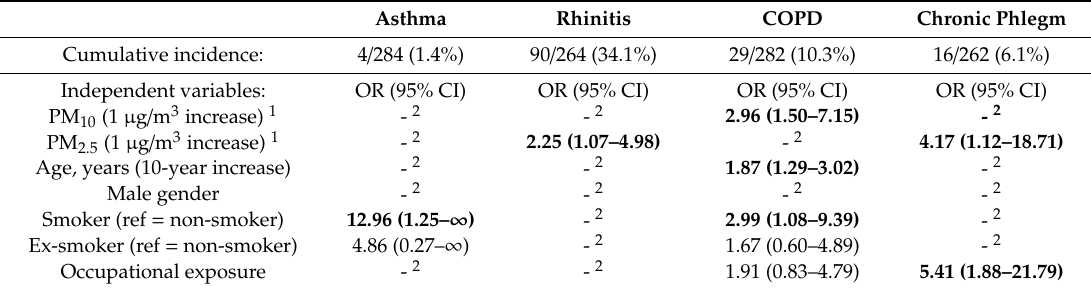
Table 2. Associations (odds ratio, OR, and 95% confidence intervals (CI)) between risk factors ascertained during the first survey (1991–1993) and cumulative incidences of asthma, rhinitis, Chronic Obstructive Pulmonary Disease (COPD) and chronic phlegm ascertained at the second survey (2009–2011), from multivariable logistic regression models with Firth’s correction.